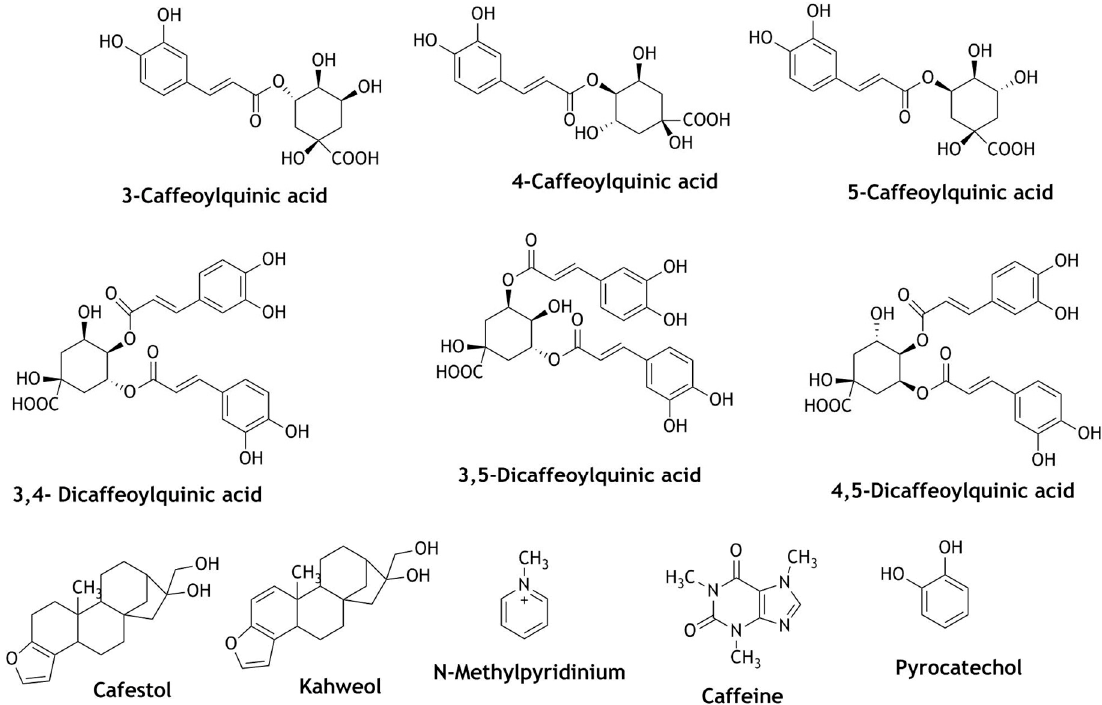
ff ee and cocoa as Nrf2